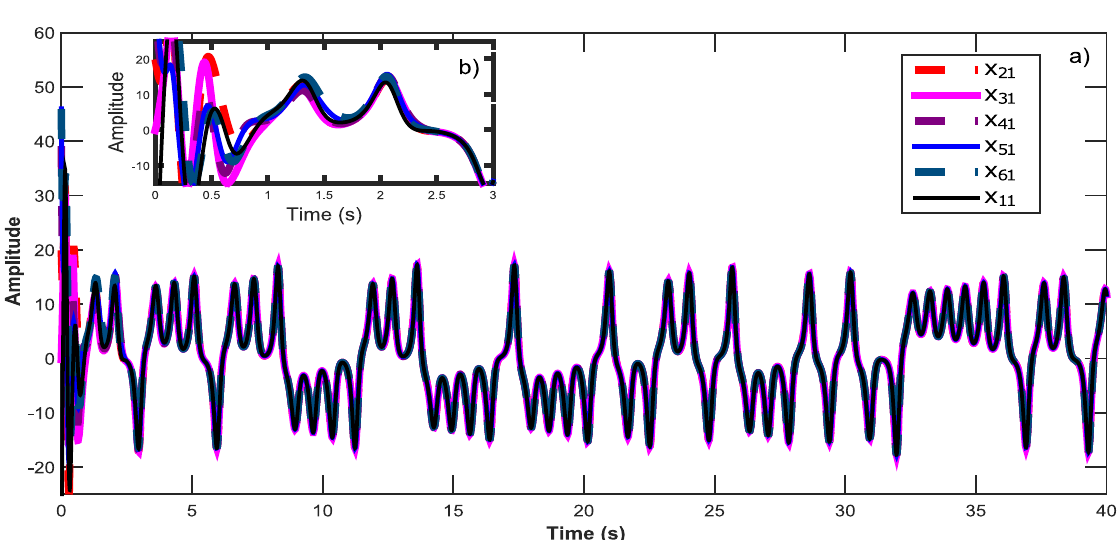
Fig 7. a) Temporal signal on the synchronization for six Lorenz chaotic systems in a ring topology. b) Zoom in window showing the convergence in time for all